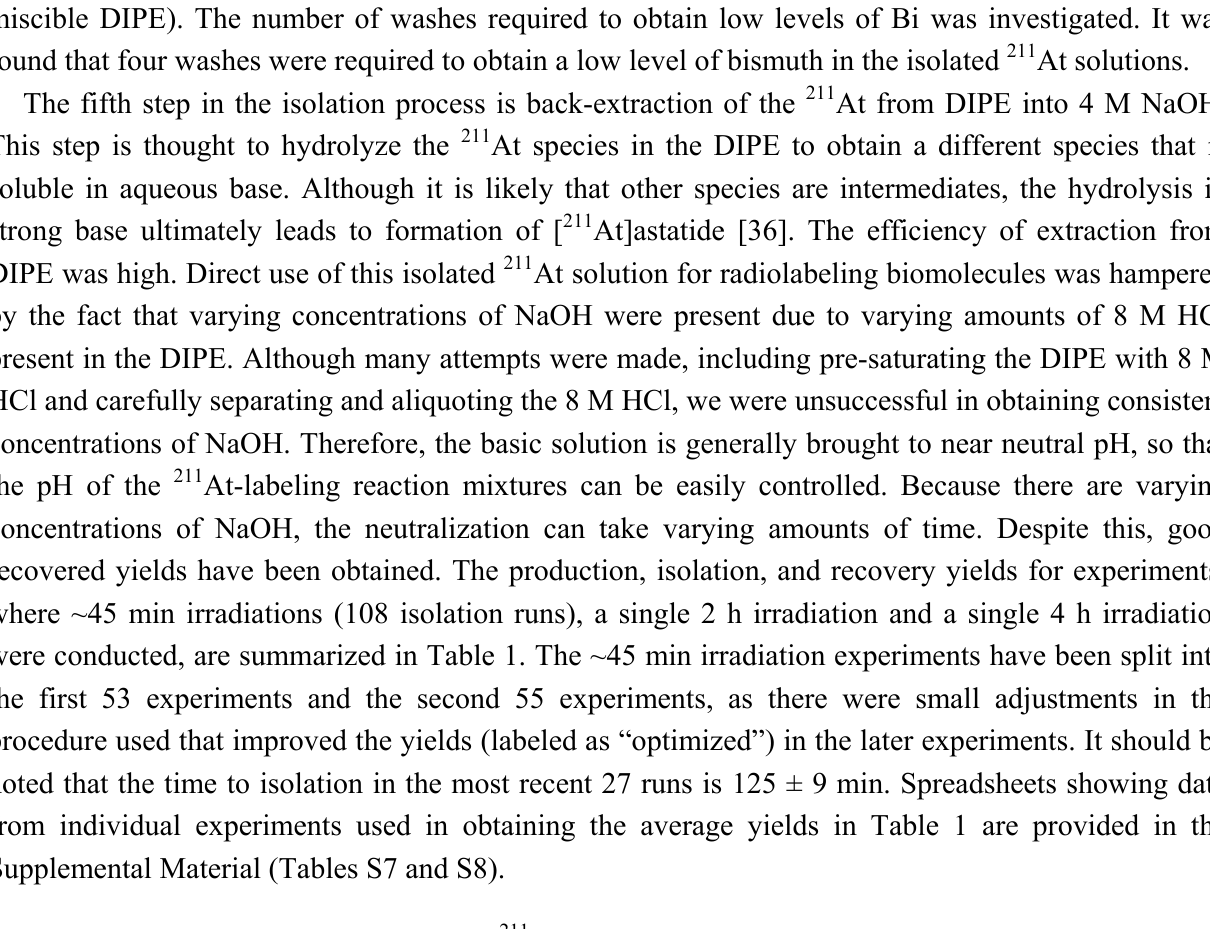
Table 1. Wet chemistry 211 At Isolation times, activity and yields